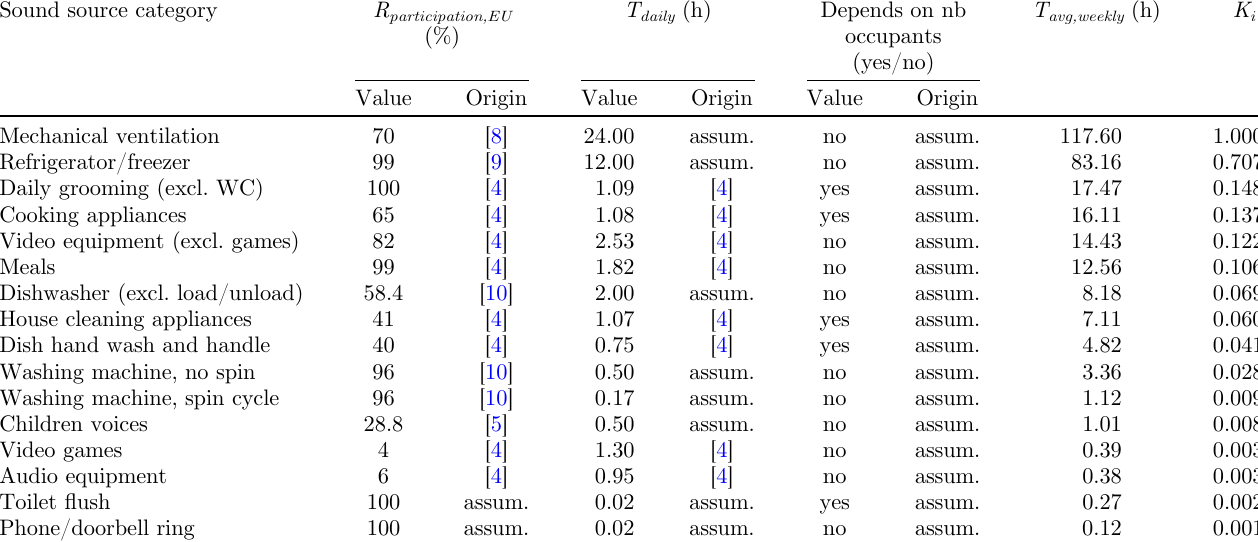
Table 1. Relative importance and associated parameters for the selected indoor sound source